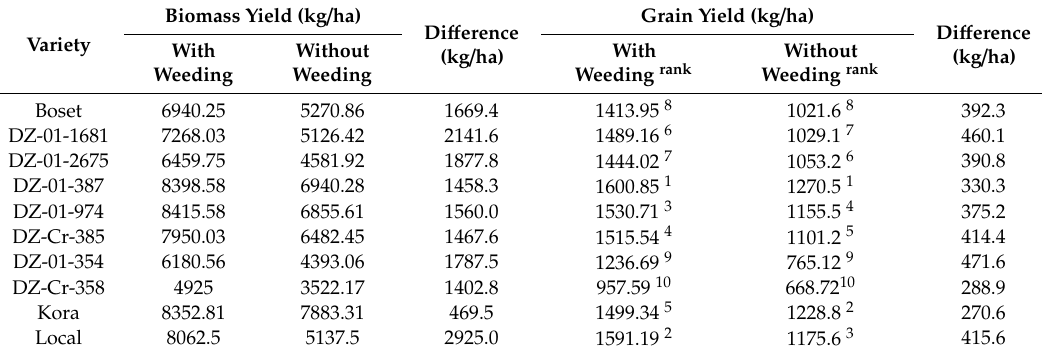
Table 8. Variation in biomass and grain yields of te ff varieties due to weeding. Grain Yield (kg / ha) Biomass Yield (kg / ha) Di ff erence Di ff erence Variety Without With Without (kg / ha)With (kg / ha) Weeding Weeding Weeding rank Weeding rank Boset 6940.25